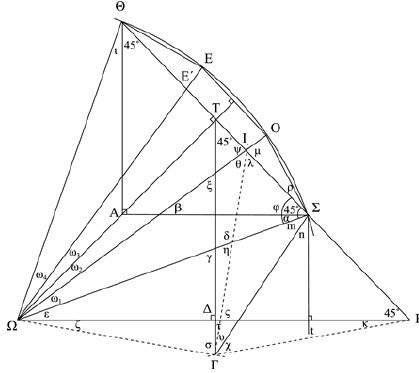
Figure 1. Construction of